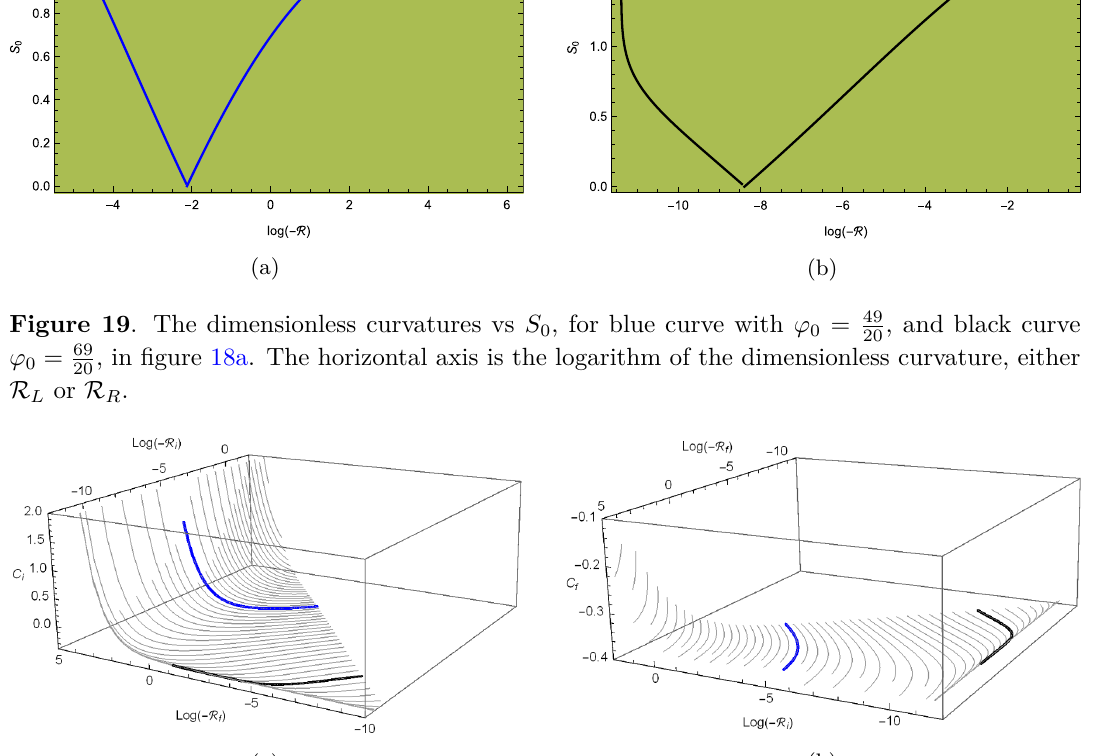
Figure 20 . As we change S 0 along a ϕ 0 = constant line in the green region in figure 18b we can read C and C in terms of the dimensionless curvatures. For example in above figures, the blue L R curve is at ϕ = 49 and the black one at ϕ 0 20